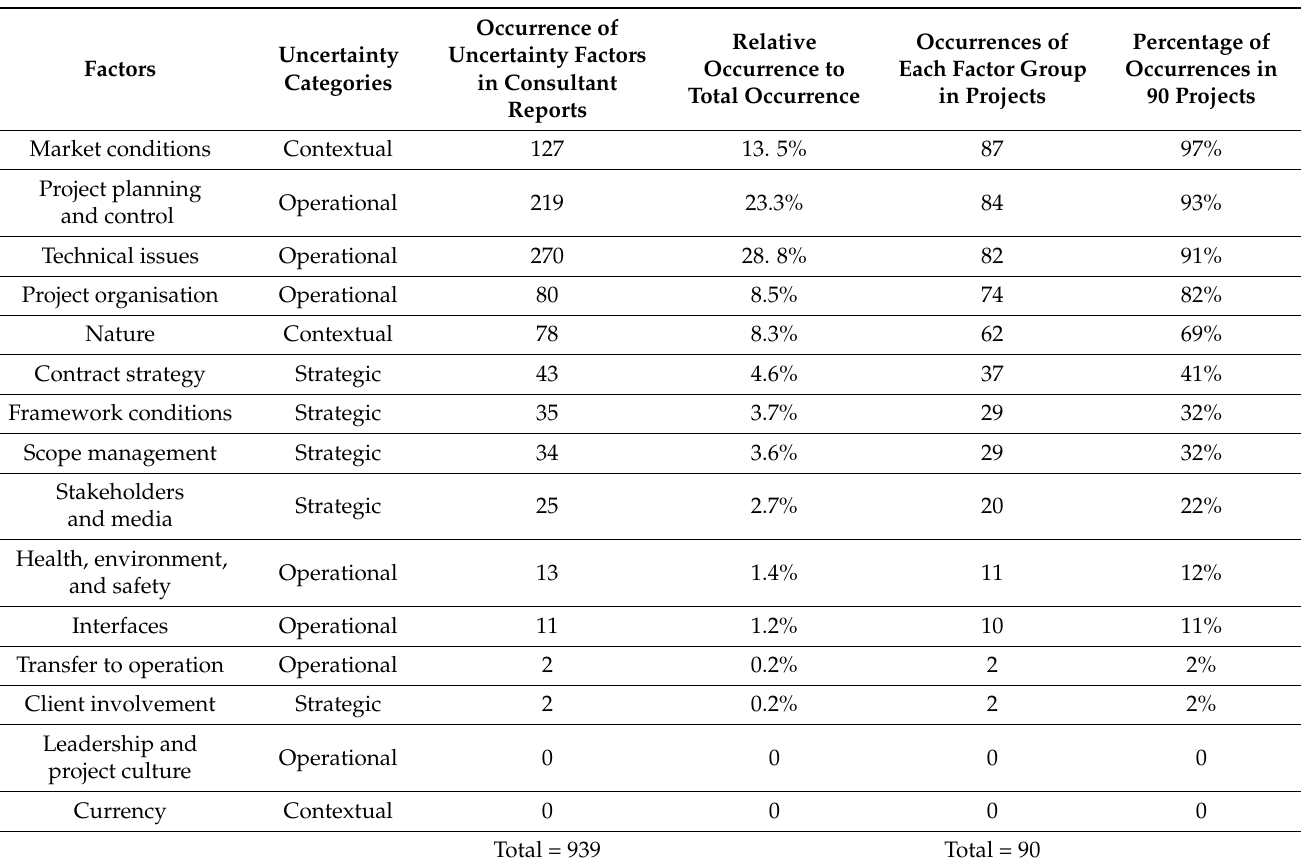
Table 2. Most common uncertainties in 90 road projects ranked by the number of